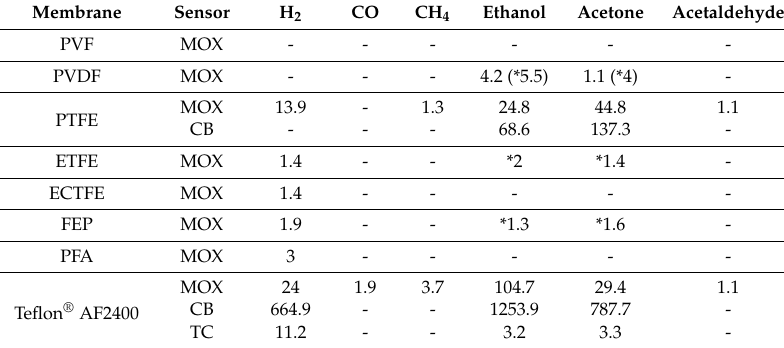
Figure 5. Separation properties of FEP, PFA and Teflon ® AF2400 upon exposure to 150 ppm H 2 , 30 ppm CO, 1000 ppm CH 4 , 500 ppm ethanol, 500 ppm acetone and 25 ppm acetaldehyde. The diameter of the membranes is 6.4 mm. Table 2. Permeate signals of the MOX, CB and TC sensors using PVF, PVDF, PTFE, ETFE, ECTFE, FEP, PFA and Teflon ® AF2400 membranes. The values given are the arithmetic mean of three measurements. For some permeate signals (*), the maximum is reached after ≥ 20 min. Membrane